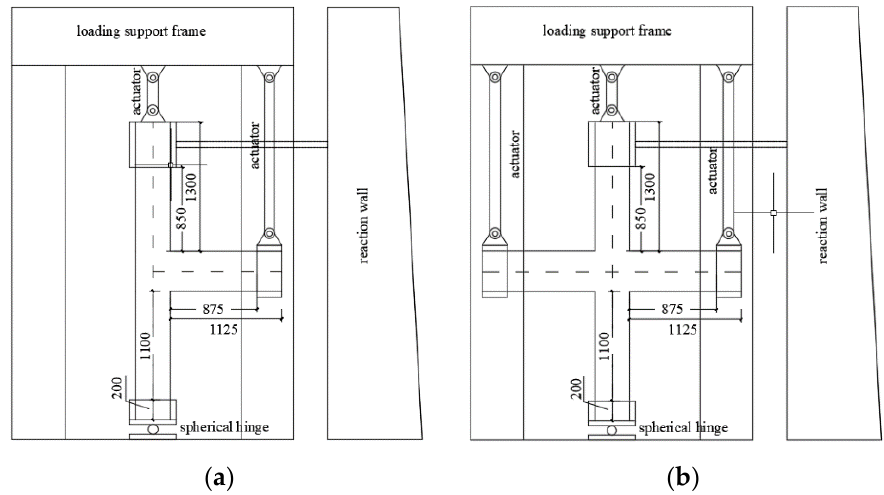
Figure 5. Schematic diagram of the loading apparatus: ( a ) exterior beam–column joint, ( b ) interior beam–column joint.